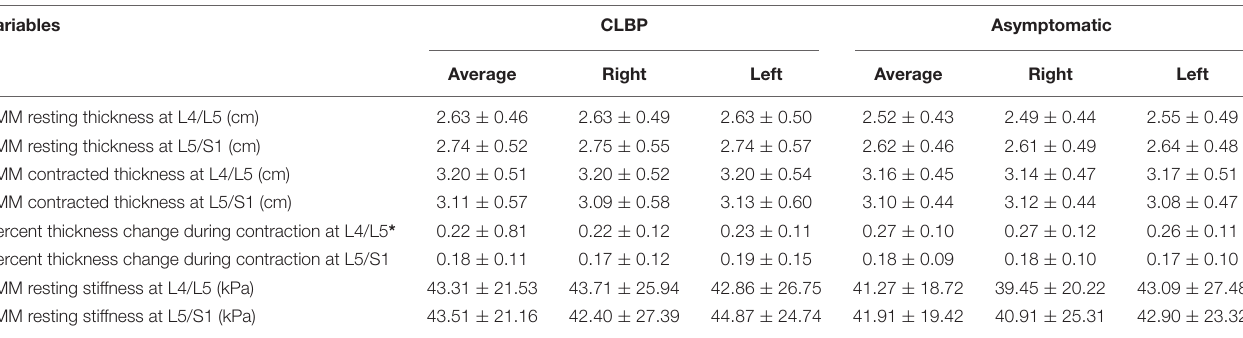
TABLE 3 | Between-group comparisons of LMM